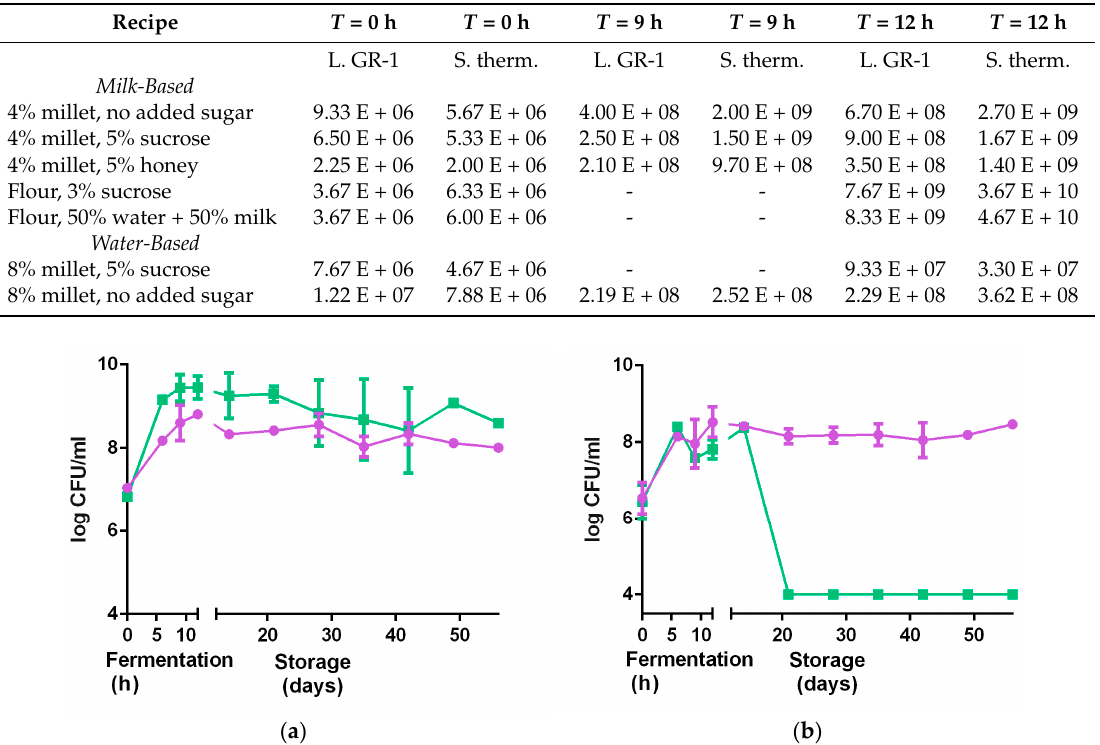
Figure 5. Changes in viable bacteria counts of L. rhamnosus GR-1 ( ● ) and S. thermophilus C106 ( ■ ) during fermentation (12 h) and refrigerated storage (56 days). ( a ) 4% millet in milk with 5% sucrose; ( b ) 10% millet in water with 5% sucrose. Error bars represent standard deviations based on two independent